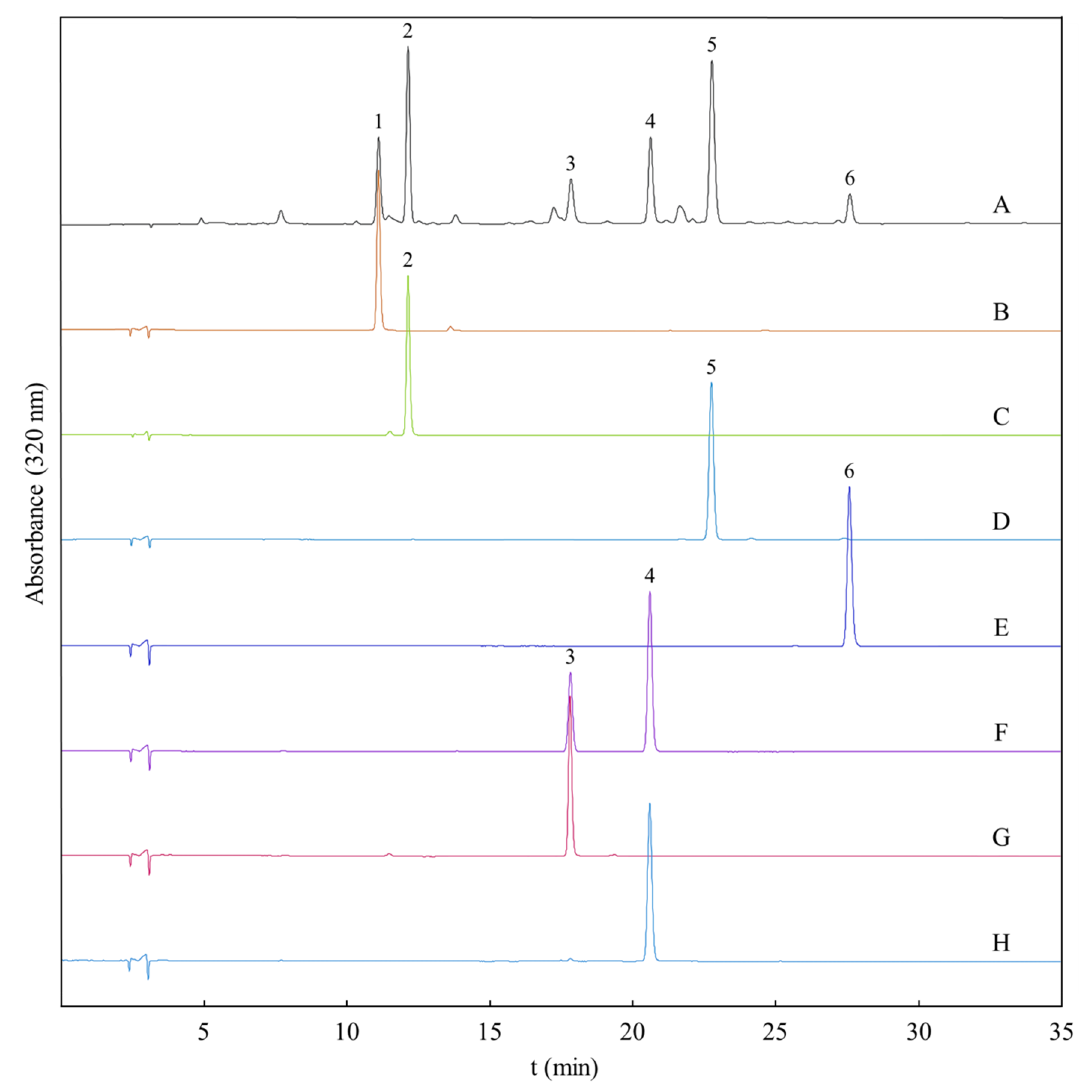
Figure 5. HPLC chromatograms of the crude extract and the isolated coumarins. Experimental conditions: Zobax SB C 18 column (5 µ m, 4.6 mm × 250 mm, i.d.); mobile phase: water ( A ) and acetonitrile ( B ) in a linear elution mode of 0–30 min, 22–55% B; 30–31 min, 55–95% B; and 34–35 min, 95–22% B. Flowrate: 1.0 mL/min; and detection: 320 nm. ( A ): crude extract; ( B ): peak II in Figure 3; ( C ): peak I in Figure 3; ( D ): peak IV in Figure 3; ( E ): peak V in Figure 3; ( F ): peak III in Figure 3; ( G ): peak I in Figure 4; and ( H ): peak II in Figure 4.